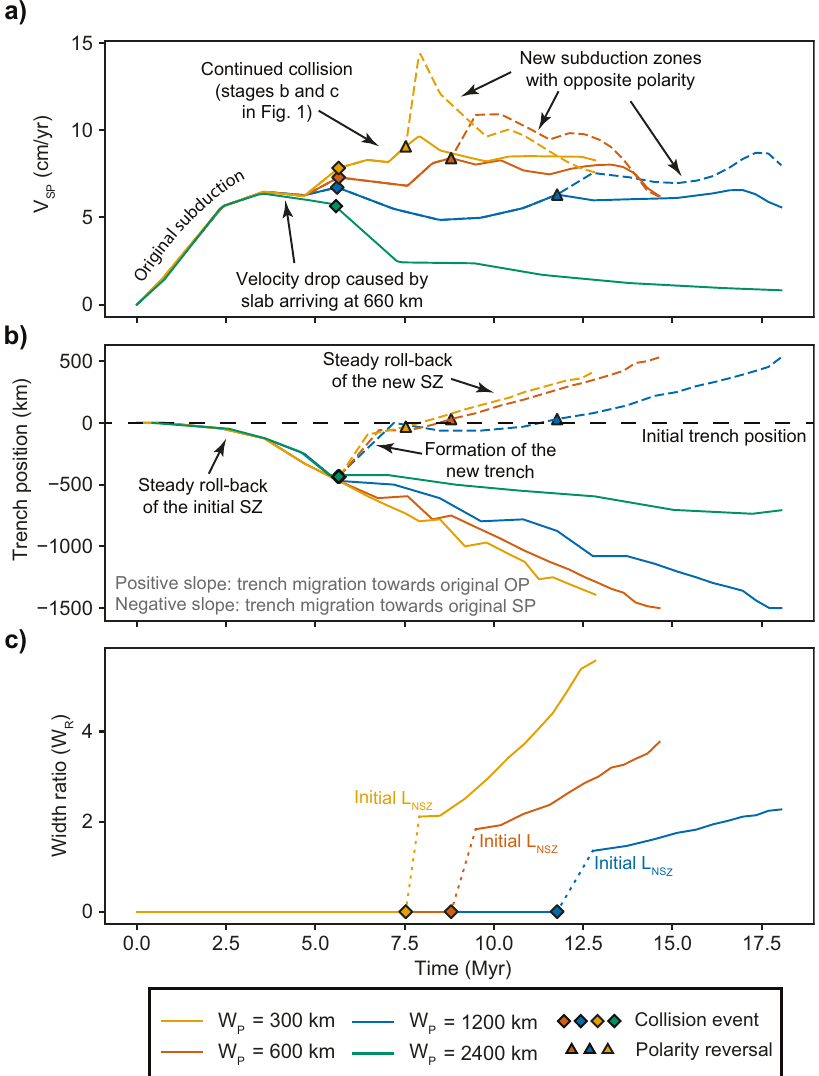
Fig. 3 Graphical depiction of the evolution of the model monitored parameters for the different considered plateau widths ( W P ). The coloured diamonds indicate the moment at which collision with the plateau is initiated, while the coloured triangles indicate the time at which full polarity reversal is achieved. The subducting plate velocity ( V SP ) is measured at the trailing edge of the subducting plate, along longitudinal sections both near the mirror symmetry boundary that cuts through the plateau (c.f. section A-A ’ in Supplementary Fig. 1), and along the opposite model boundary that crosses only the initial intra-oceanic subduction zone. a Evolution of subduction plate velocity ( V SP ) over time (subduction plate acceleration), for the original subduction zone (full lines), and for the newly formed opposite dipping one (dashed lines). Note that narrower plateaus imply a smaller indentation area and accompanying lower energy dissipation, resulting in both higher V SP values and plate accelerations. Narrower plateaus also lead to an early trigger of polarity reversal events, expressed by the diminishing distance between diamonds and triangles in the graph. b Subduction trench migration as a function of time (trench velocity), for the original subduction zone (full lines) and for the newly formed subduction trench (dashed lines). The plateau collision event causes an abrupt migration of the newly forming trench towards the overriding plate (OP), even before the new opposite dipping subduction zoned is fully formed. c Plateau indentation ef fi ciency, expressed by the time evolution of the W R ratio (see Supplementary Fig. 1B) between the growing length of the new subduction zone ( L NSZ ) and the original along-trench width of the plateau ( W P ). As no new subduction zones are formed before the collision of the plateau with the overriding plate, W R values prior to this event are always zero. Narrower plateaus create notably longer subduction zone trenches relative to their initial widths. The W P = 2400 km line was not included in ( c ) due to the lack of a polarity reversal event. SZ subduction zone, OP overriding plate, SP subducting plate, L NSZ length of new subduction four different initial along-trench widths of the plateau were tested (between 300 and 2400 km, see Supplementary Table 1 and Supplementary Fig. 1). Note that a wider plateau implies a nar- in turn leads to a stronger slab pull (higher effective slab pull F SP / W SP , see Supplementary Table 2). The evolution of these models can be seen in Supplementary Movies 1 – 4.